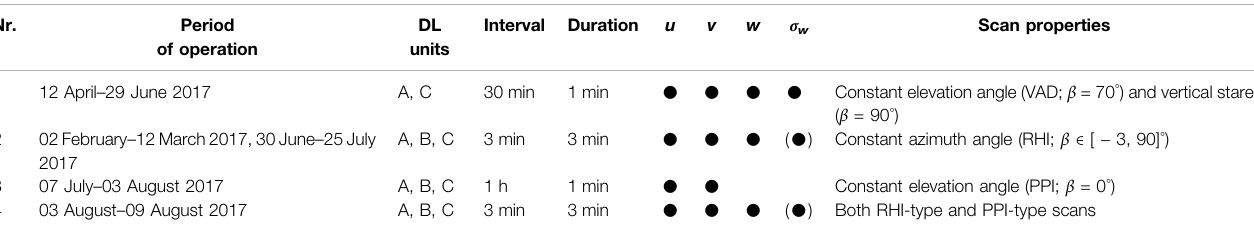
TABLE 1 | Concerted Doppler lidar (DL) scan routines during the 2017 experimental campaign in Stuttgart City Centre.